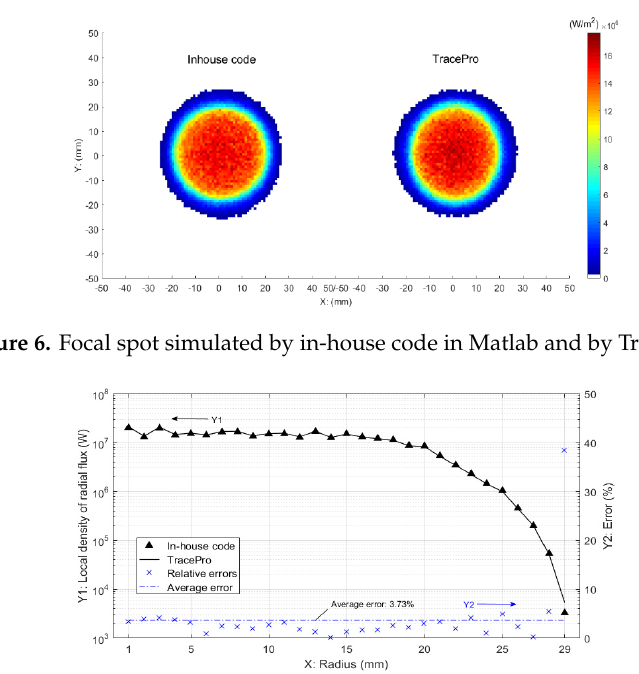
Figure 7. Comparison of local density distributions of spots simulated by TracePro ® and in-house code.